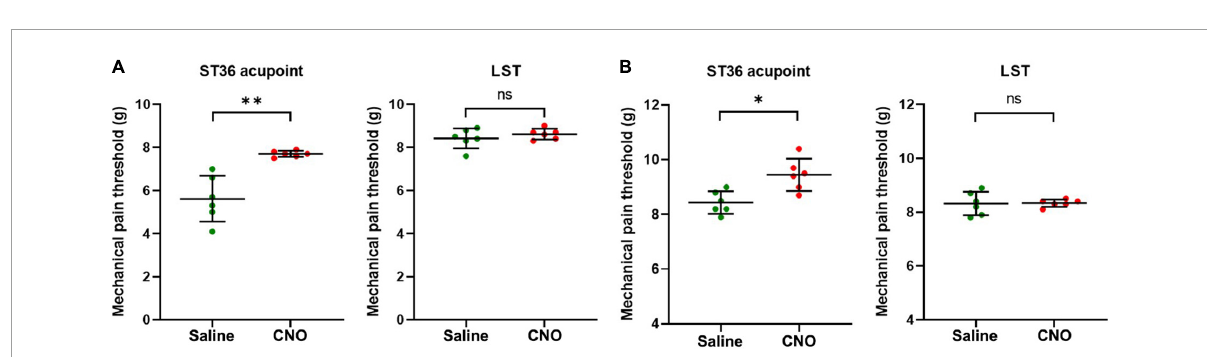
FIGURE4 Inhibition of shared neurons elevated the mechanical pain threshold of ST36 acupoint. (A) The CNO treatment increased the mechanical pain thresholds of the ipsilateral ST36 acupoint but not the LST in the CFA model. n = 6, paired t -test. For ST36 acupoint, ∗∗ P = 0.0032. For LST, P = 0.3632. LST, the position 5 mm lateral side of the ST36. (B) The CNO treatment increased the mechanical pain thresholds of the ipsilateral ST36 acupoint but not the LST in the normal mice. n = 6, paired t -test. For ST36 acupoint, ∗ P = 0.0284. For LST, P =